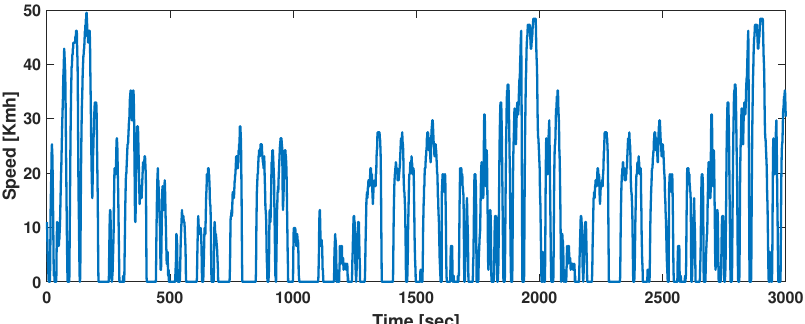
Figure 10. Route 2: The route around local areas of the city, a short route around the city with medium-traffic roads.